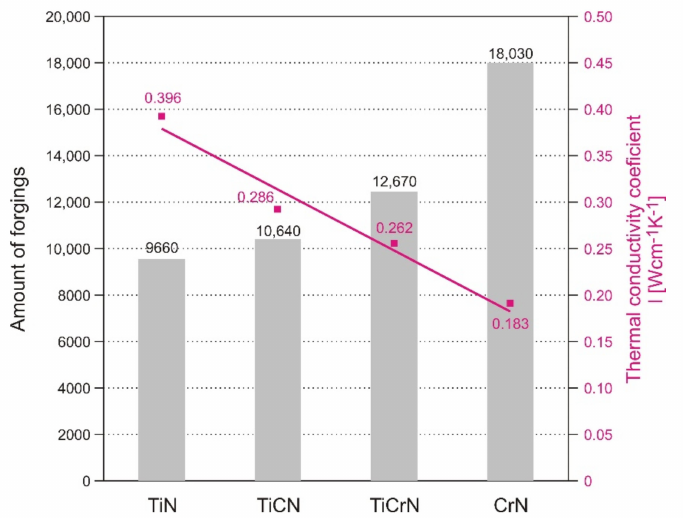
Figure 6. Comparison of the forging dies durability covered with hybrid layers: “nitrided layer + PVD coating”, with the value of the thermal conductivity coefficient ( λ ) of various PVD coatings. Reprinted from permission from [56]. Copyright 2016 the Łukasiewicz Research Network—Institute for Sustainable